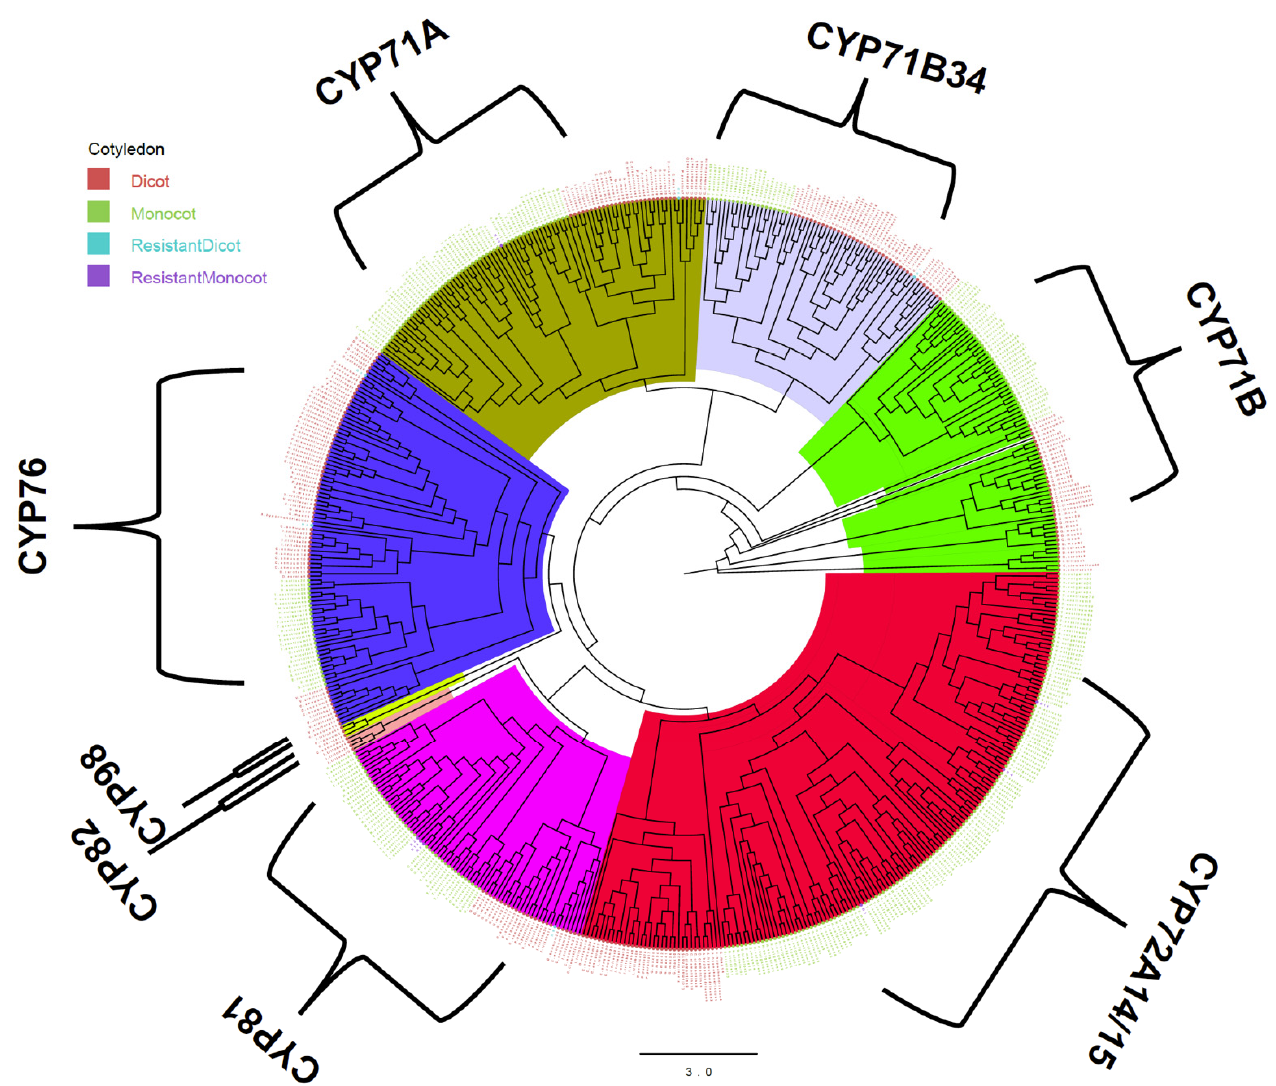
Figure 1. Phylogenetic tree of the CytochromeP450 genes. The tree was constructed using the maxi- mum likelihood statistical technique with 1000 bootstrap repetitions. The letters in red, green, violet, and blue legend represents dicot, monocot, CYP450 resistant monocot, and CYP450 resistant dicot. The scale bar for evolutionary distance is 3.0. Major clades are highlighted with colors: CYP76 (blue), CYP71A (dark green), CYP71B34 (light blue), CYP71B (green), CYP72A14/15 (red), CYP81 (pink), CYP82 (orange), and CYP98 (light green).